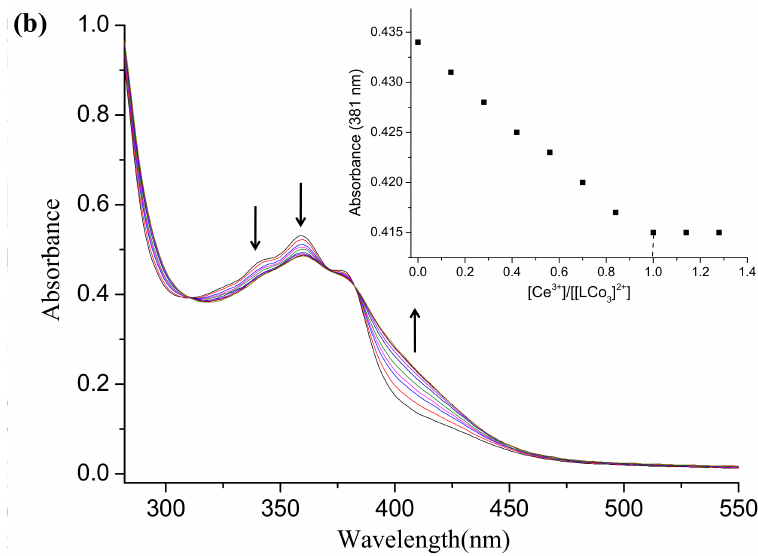
Figure 3. ( a ) UV-Vis spectral changes of the H 4 L (2.5 × 10 − 5 M) on addition of Co(II) (1.0 × 10 − 3 M)